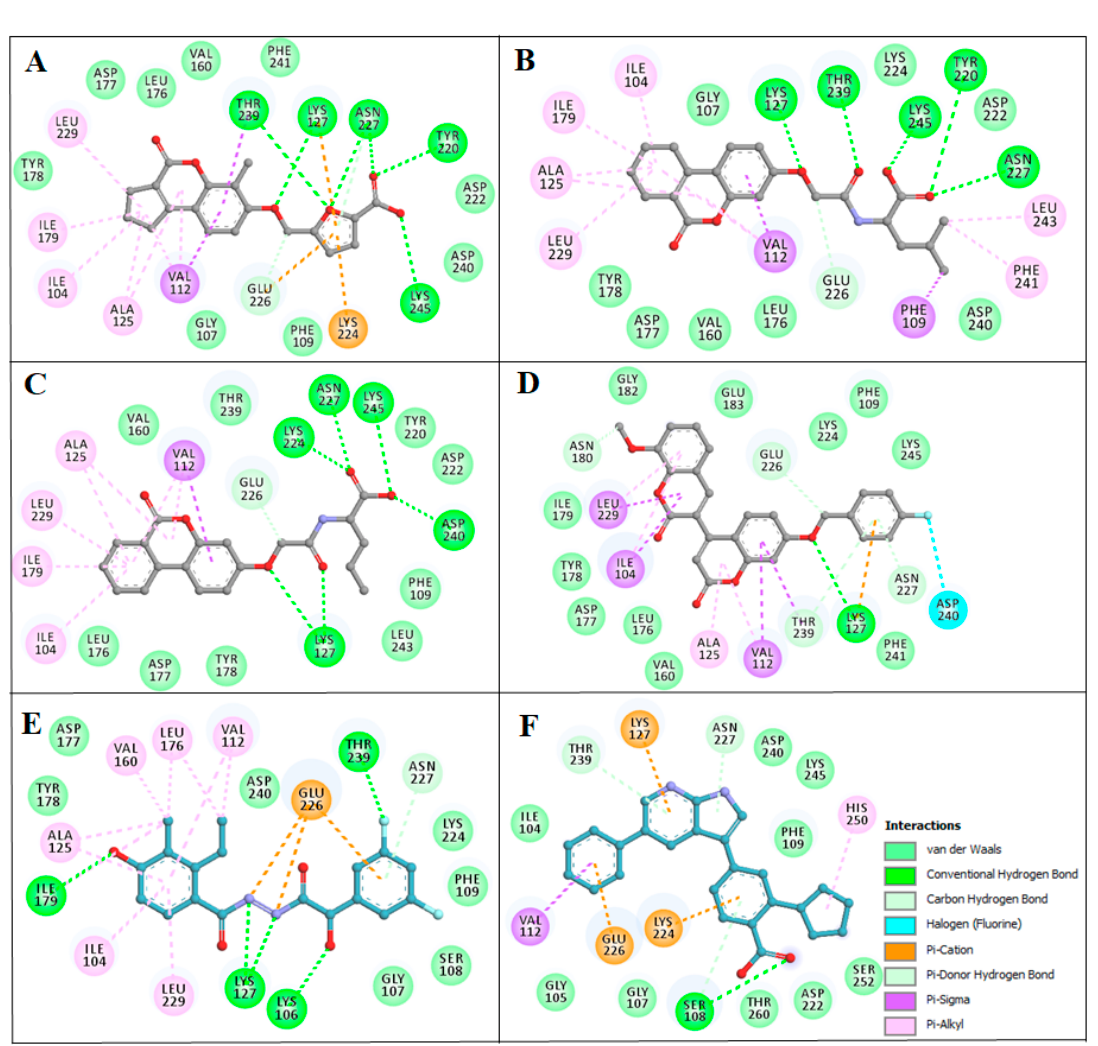
Figure 4. Two-dimensional (2D) structural representation of SGK1 residues interacting to the compound ( A ) ZINC00319000, (B) ZINC02106991, ( C ) ZINC02115387, ( D ) ZINC02121074, ( E